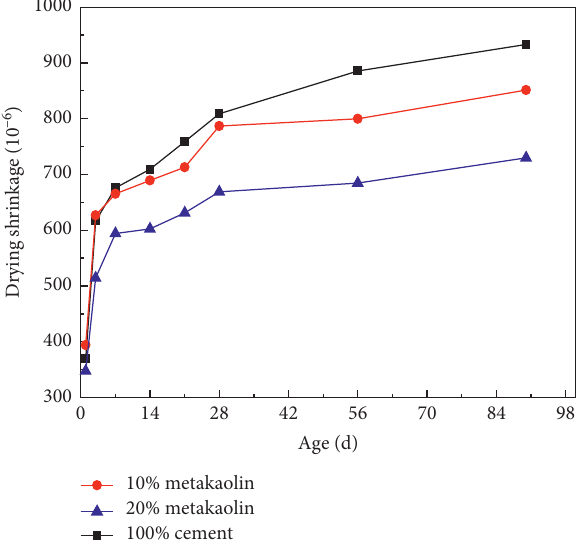
Figure 17: Effect of PCE-2 and slag dosage on drying shrinkage of cement mortar.